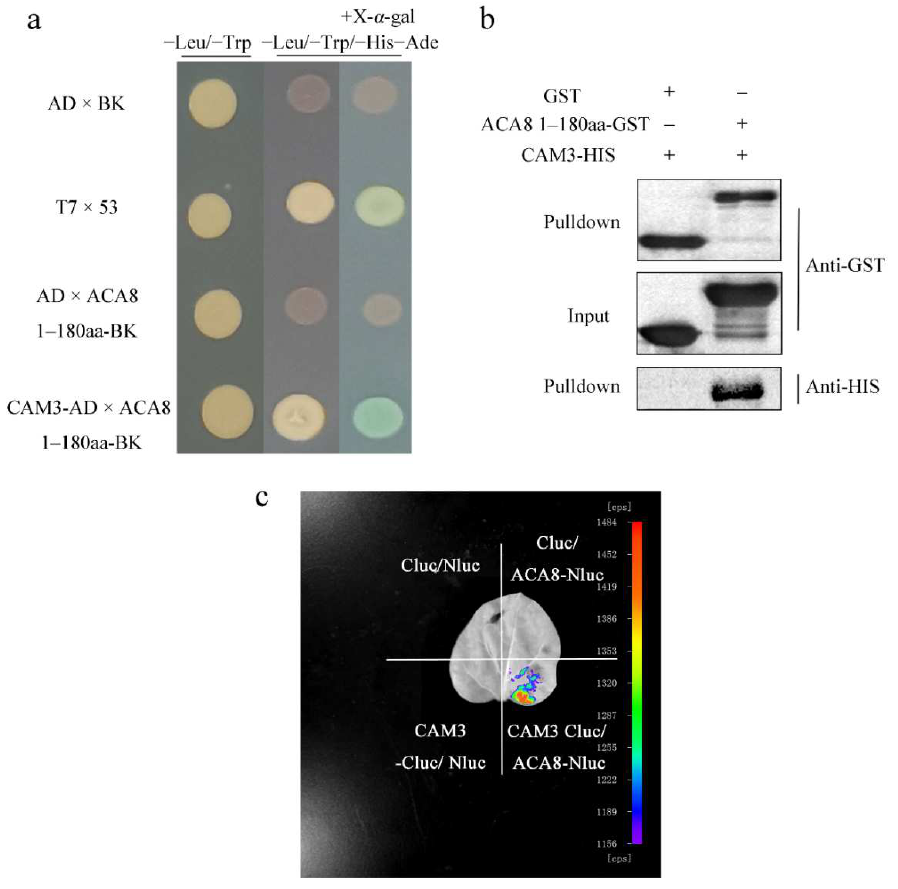
Figure 5. CAM3 interacts with ACA8. ( a – c ) Y2H, in vitro pulldown, and LCI assays show that CAM3 interacts with ACA8. ( a , b ) In the Y2H and in vitro pulldown assays, because ACA8 is a membrane protein, the N-terminus (residues 1–180), an intracellular domain, was used to interact with CAM3. ( c ) N. benthamiana leaves were divided into four parts: the bottom right part was an experimental group, and the others were control groups. Red represents the maximum fluorescence intensity.